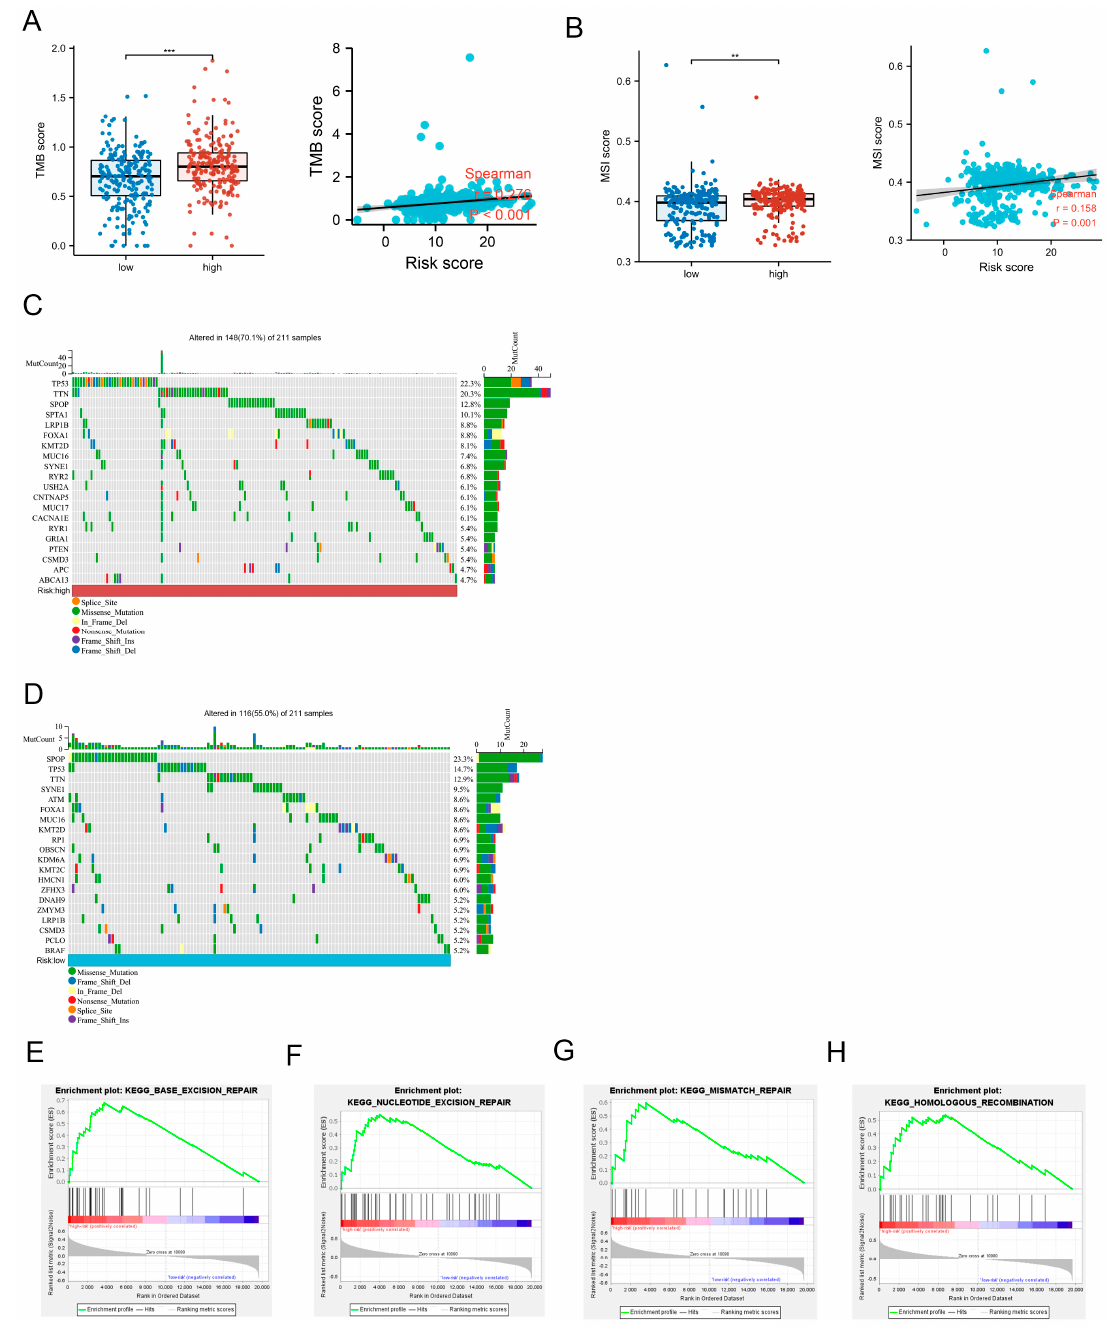
Figure 7. Mutational landscape and single sample GSEA analysis in high-risk and low-risk groups of prostate cancer. ( A ) TMB scores difference between high-risk and low-risk groups, and correlation with risk score. ( B ) MSI scores difference between high-risk and low-risk groups, and correlation with risk score. ( C ) The waterfall plot of top 20 most mutated genes in the high-risk group. ( D ) The waterfall plot of top 20 most mutated genes in the low-risk group. ( E – H ) The repair of DNA damage mechanisms of GSEA analysis in the high-risk group. ** p < 0.01, *** p < 0.001.